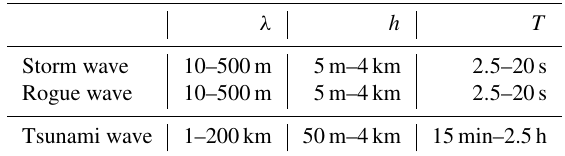
Table 1. Classification of short waves (storm waves, rogue waves) and long waves (tsunamis) according to their wavelength, depth and period. Note that storm surges are not included as the range of pa- rameters is difficult to